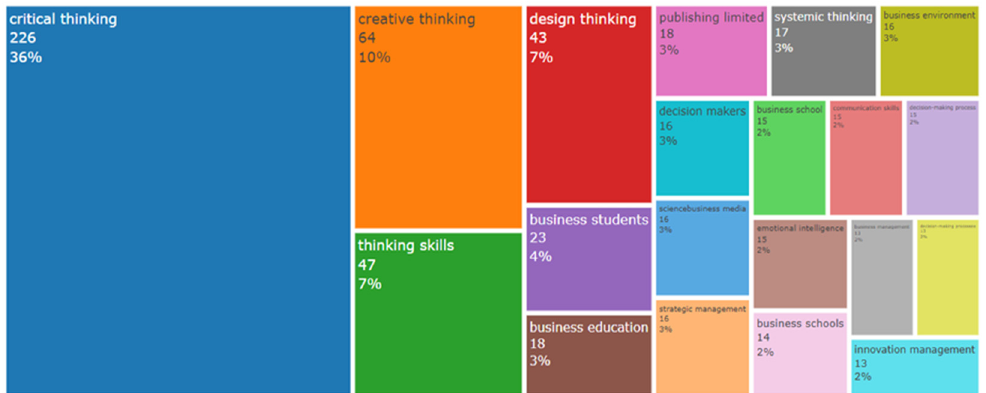
Figure 6. Most frequently used keywords in the articles. Source: Created by the authors through Bibliometrix.